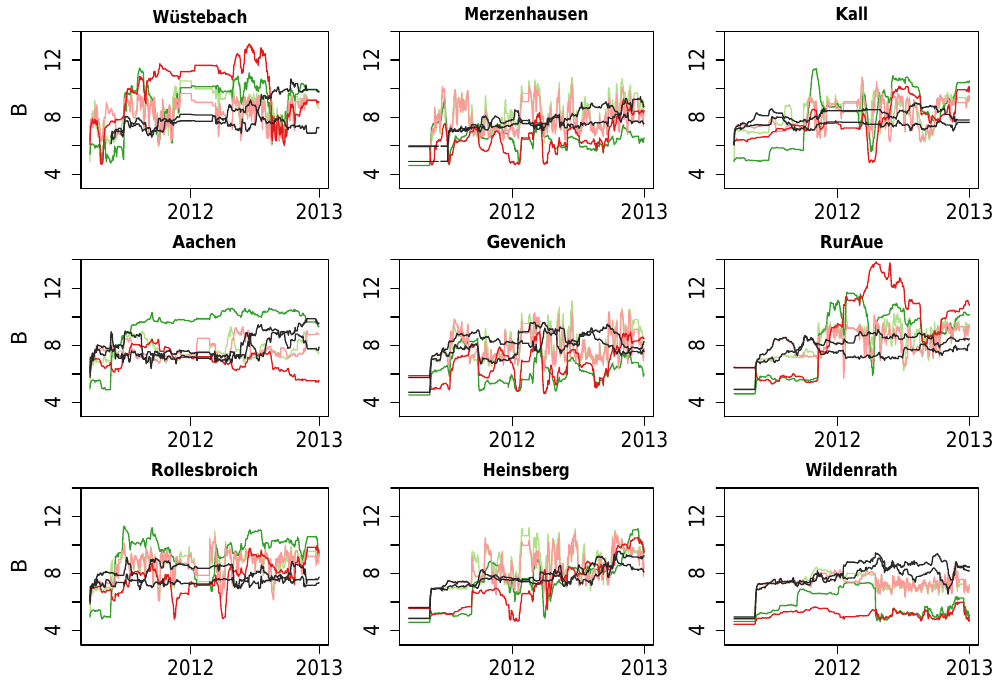
Figure 6. At nine sites, estimates of the B parameter (top 15cm) are shown for simulations with parameter update: PAR-S80-30 (green), PAR-S80-10 (light green), PAR-BK50-30 (red), PAR-BK50-10 (light red), jk8-S80- ∗ (black) and jk8-BK50- ∗